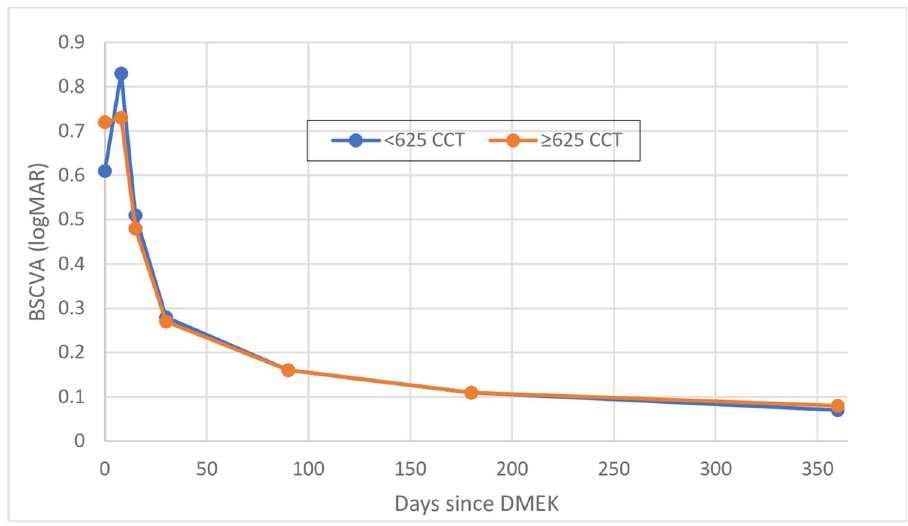
Fig 3. Change in BSCVA in eyes with low ( < 625 μ m) and high ( � 625 μ m) preoperative CCT. BSCVA, best spectacle-corrected visual acuity; CCT, central corneal